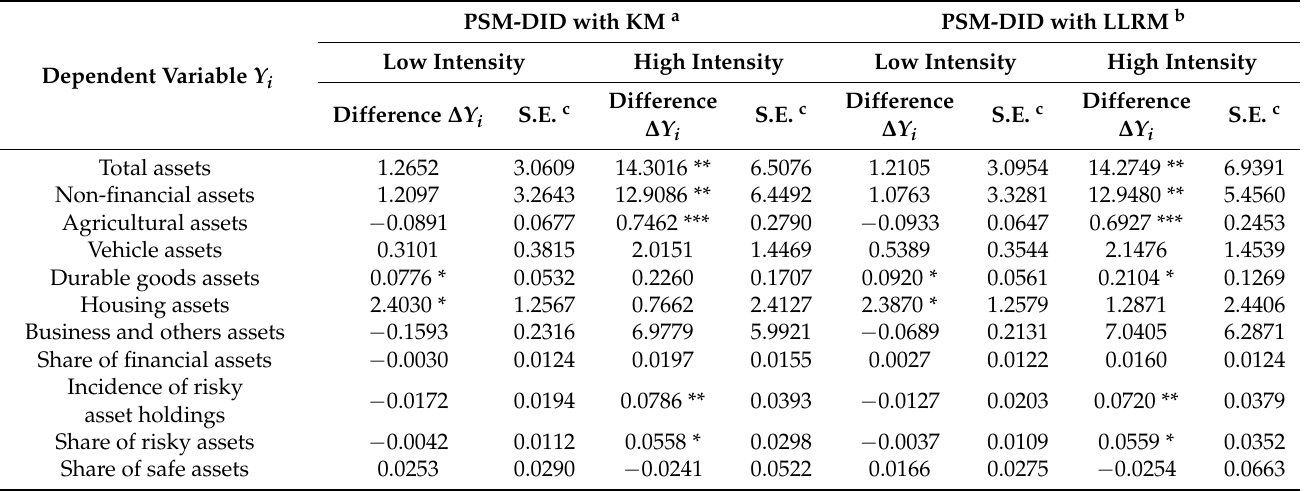
Table 6. Results of impact of land market participation on household asset allocation by the tenancy